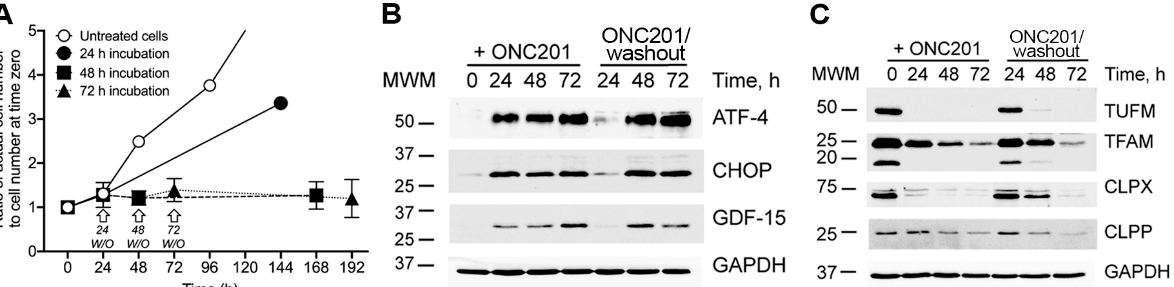
Figure 4. Time-dependent effect of single dose ONC201 exposure of BT474 cells on proliferation and expression of markers of ISR. ( A ), Proliferation of BT474 exposed to 10 µM ONC201 and following washout (marked with arrows). ( B ), Representative Western blots of markers of ISR (ATF4 and CHOP) and stress-protein GDF-15 following treatment with 10 µM of ONC201 (+ONC201) and subsequent 120 h washout ( − ONC201(washout)); ( C ), Representative Western blots of mitochondrial proteins following treatment with 10 µM of ONC201 (+ONC201) and subsequent 120 h washout ( − ONC201(washout)). Shown are mean ± SD ( A ) and representative Western blots ( B , C ) from at least three independent experiments.